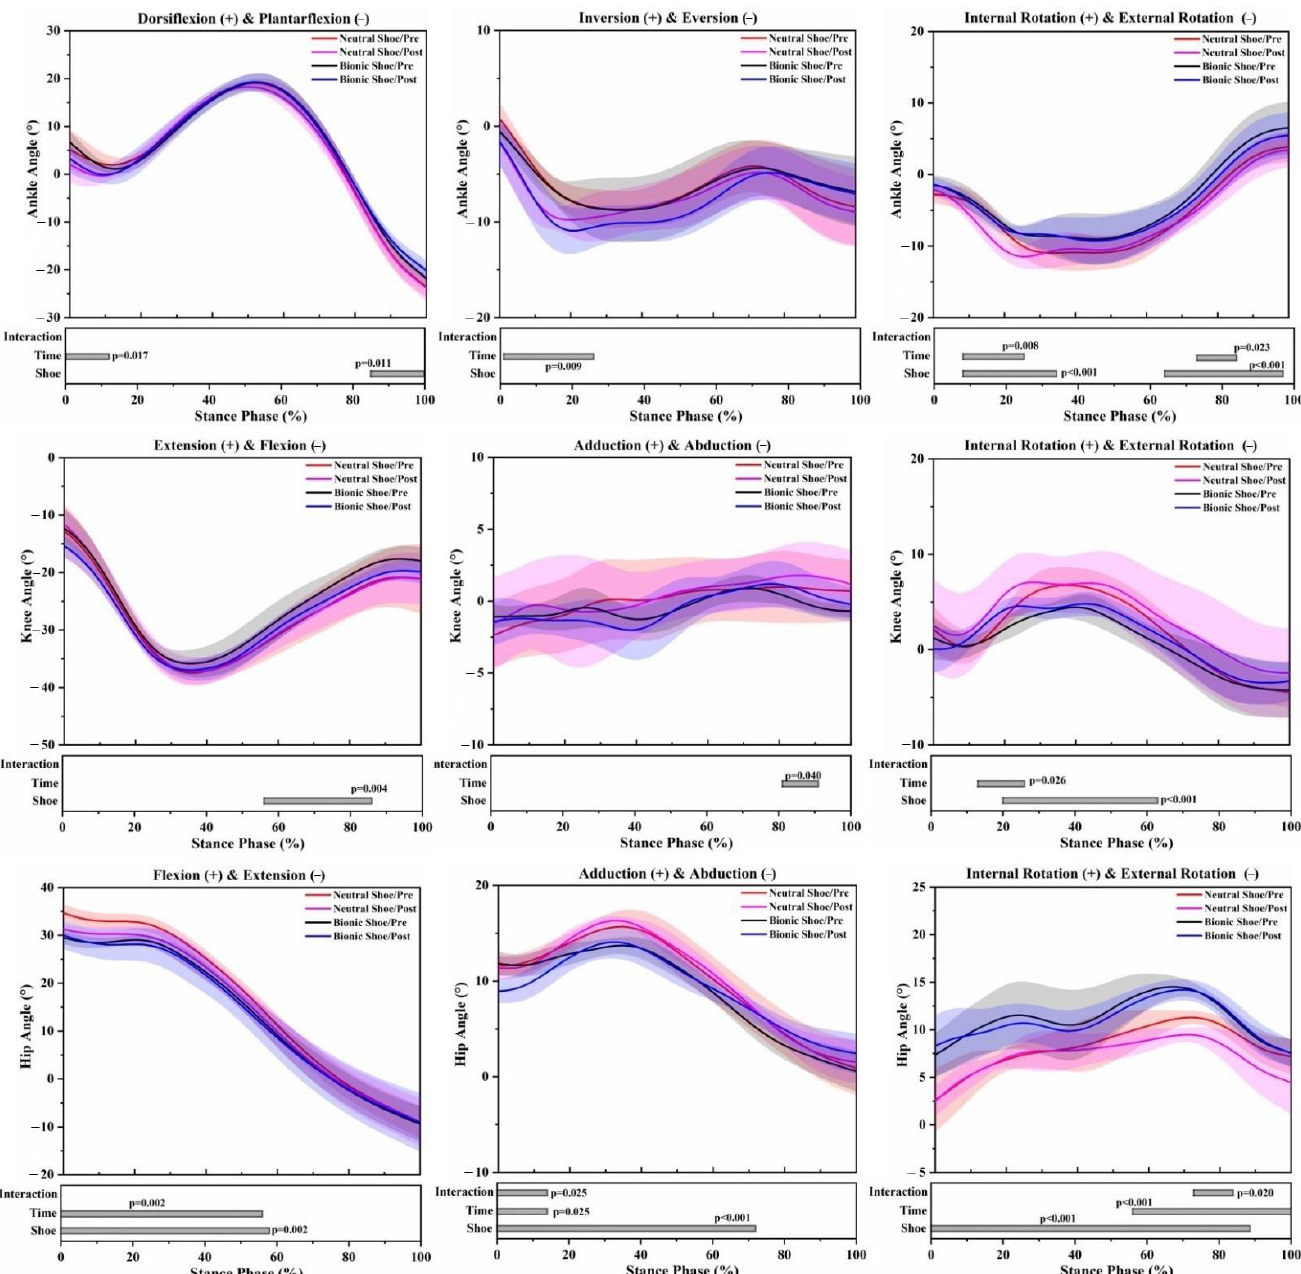
Figure 3. Lower limb joint angle waveforms of mean and standard deviation over the stance phase of 4 running conditions. Significant main effects of the shoe, time and interaction ( p < 0.05) are highlighted (grey horizontal bars at the bottom of the figure) during corresponding periods from SPM1d